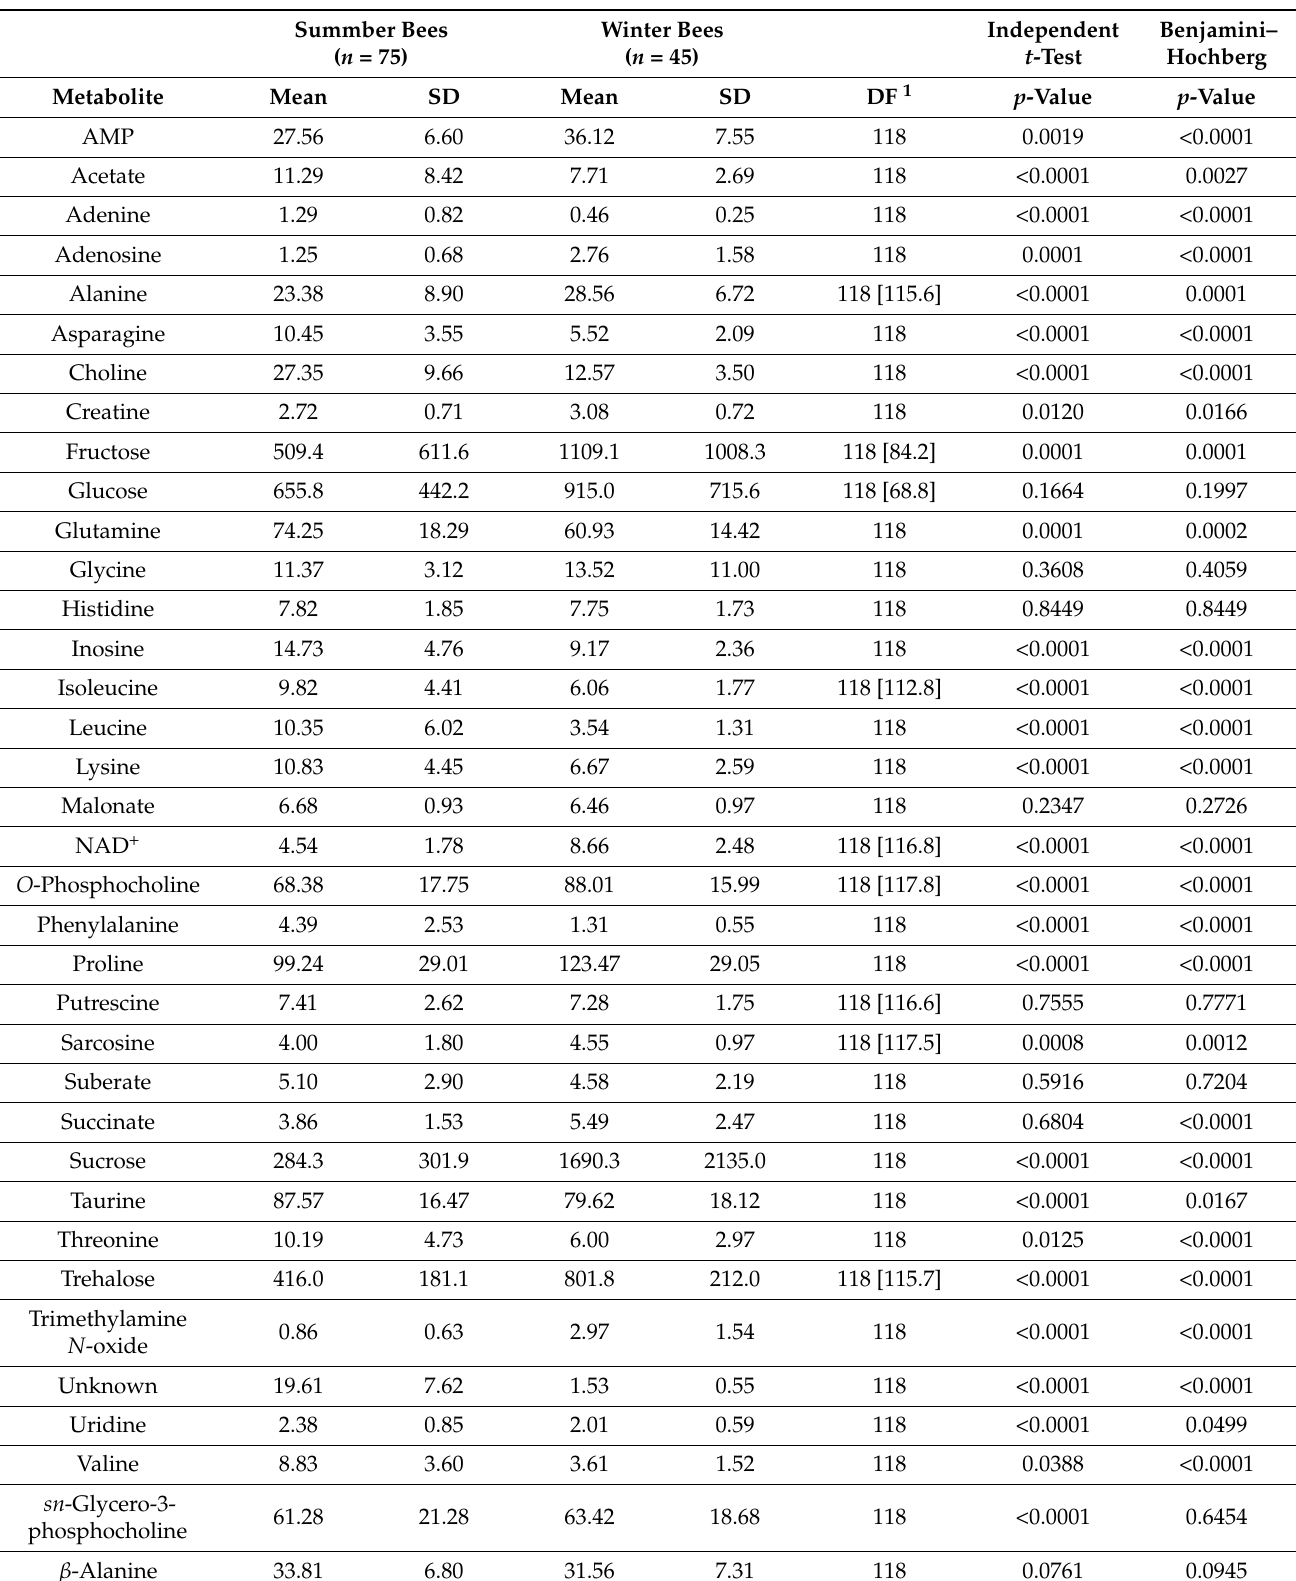
Table 1. Mean ( µ g/bee), standard deviation (SD), independent t -test, and Benjamini–Hochberg’s procedure (FDR